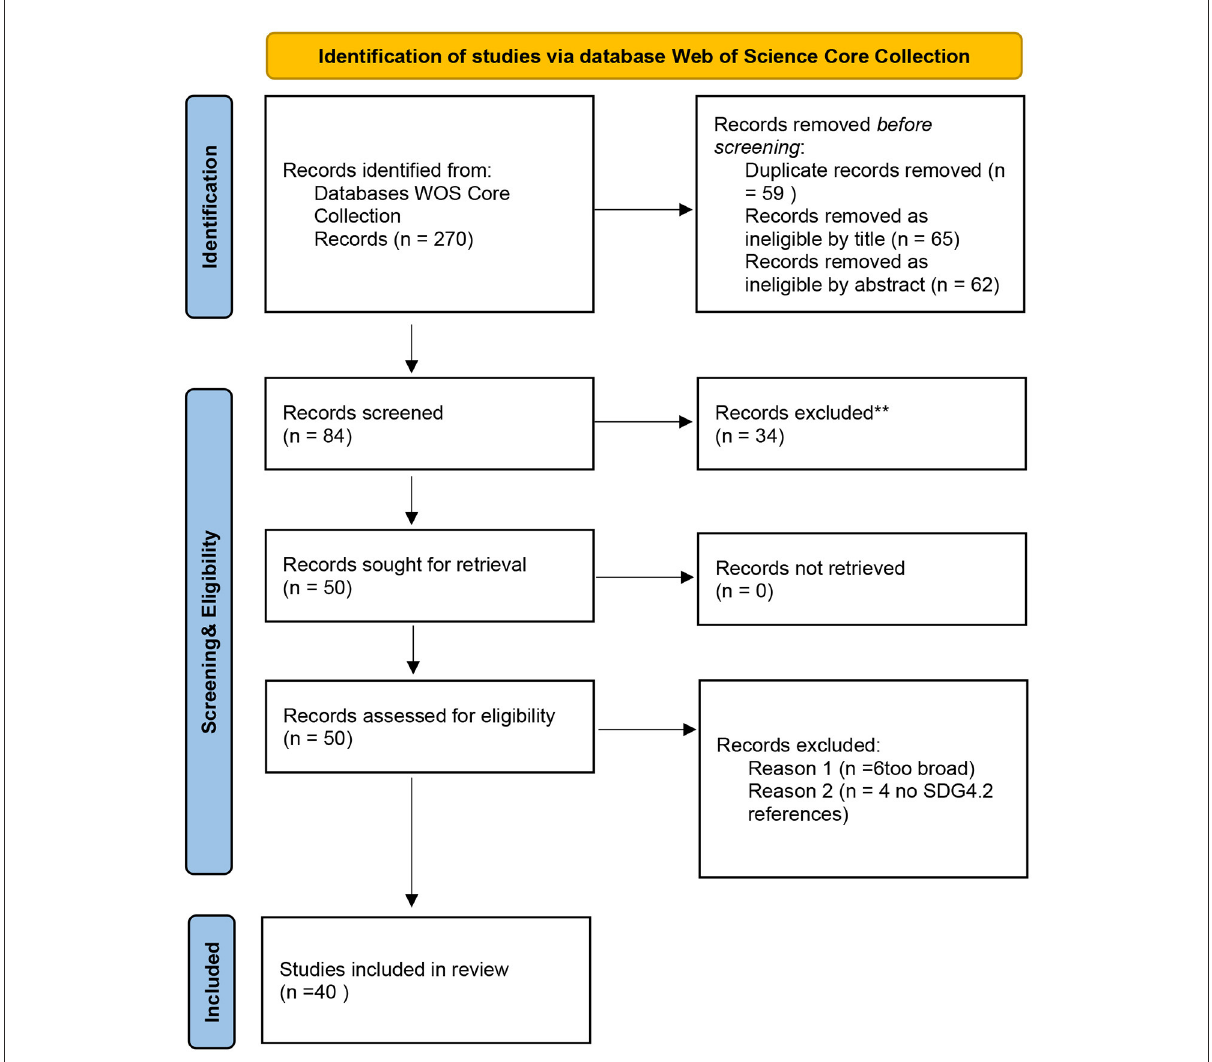
FIGURE1 PRISMA flow diagram for inclusive and equitable quality early childhood education for achieving SDG4